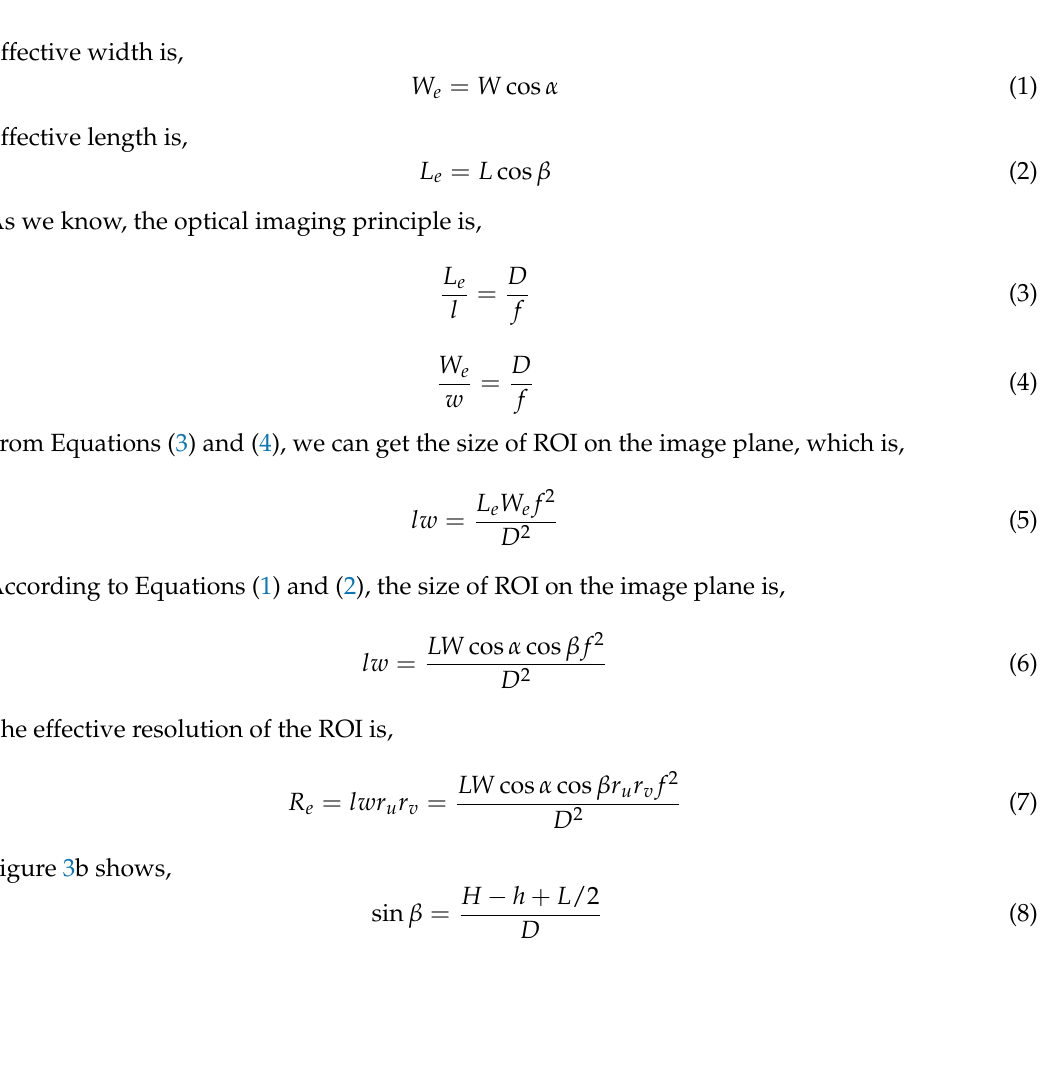
Figure 3. ( a ) The vertical view of 3D sensing model based on ROI; ( b ) The lateral view of 3D sensing model based on